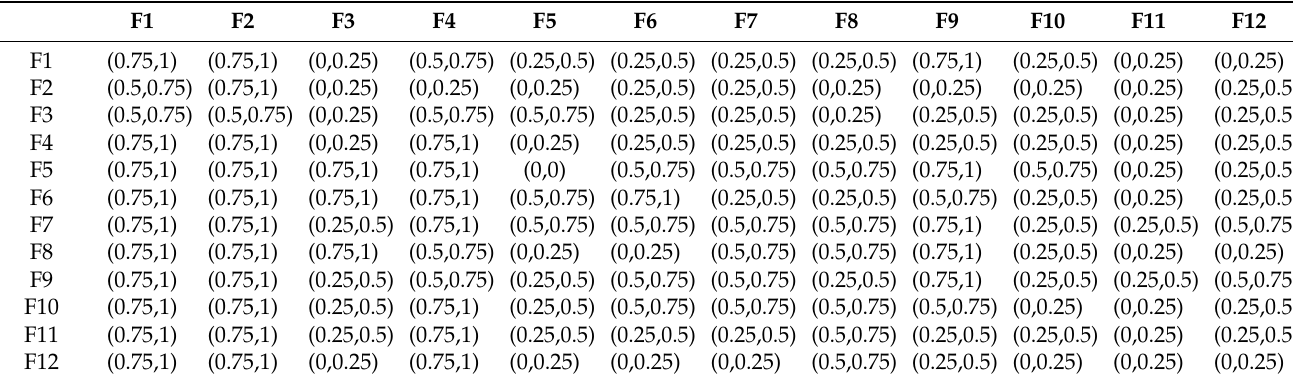
Table 7. The grey initial strength relationship matrix from Exp